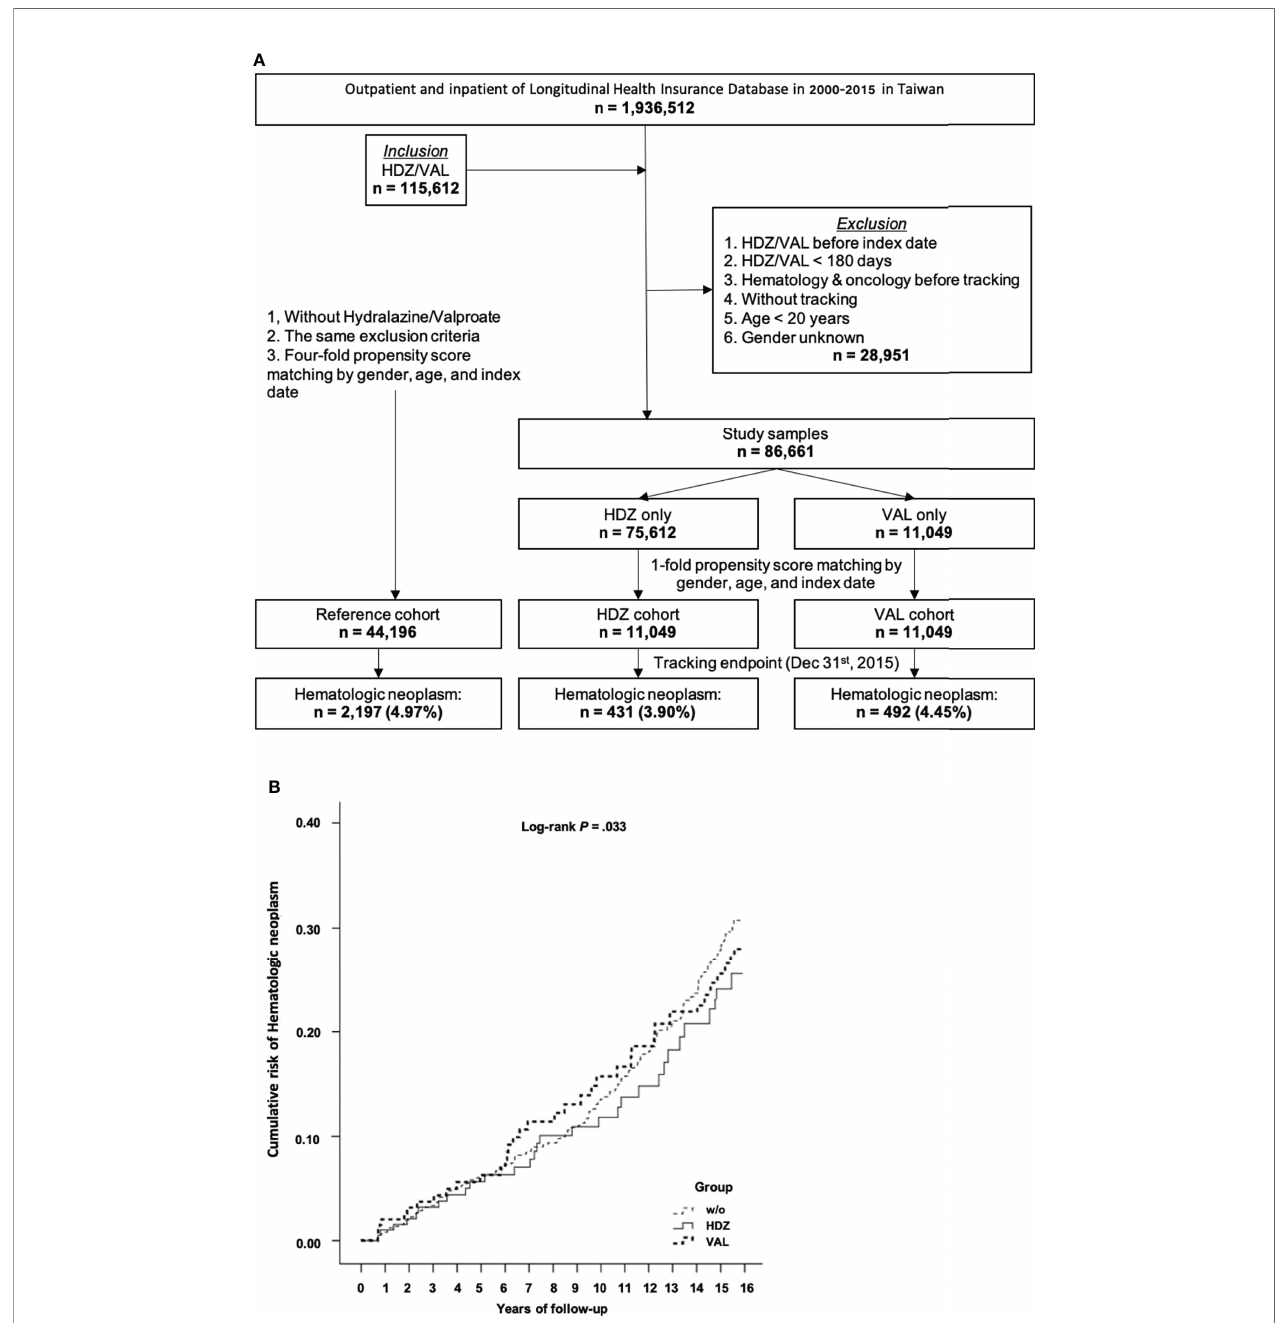
FIGURE 2 | A cohort study for association of HN incidence reduction with HDZ or VAL. (A) A fl ow chart showing the steps for sample-subject selection for the cohort study based on chronic prescription of HDZ and VAL. (B) The Kaplan – Meier curve of the cumulative incidence of being diagnosed with HN among the different groups with log-rank test. Log-rank test: without vs. hydralazine, p <.001; without vs. valproate, p = .067; hydralazine vs. valproate, p =